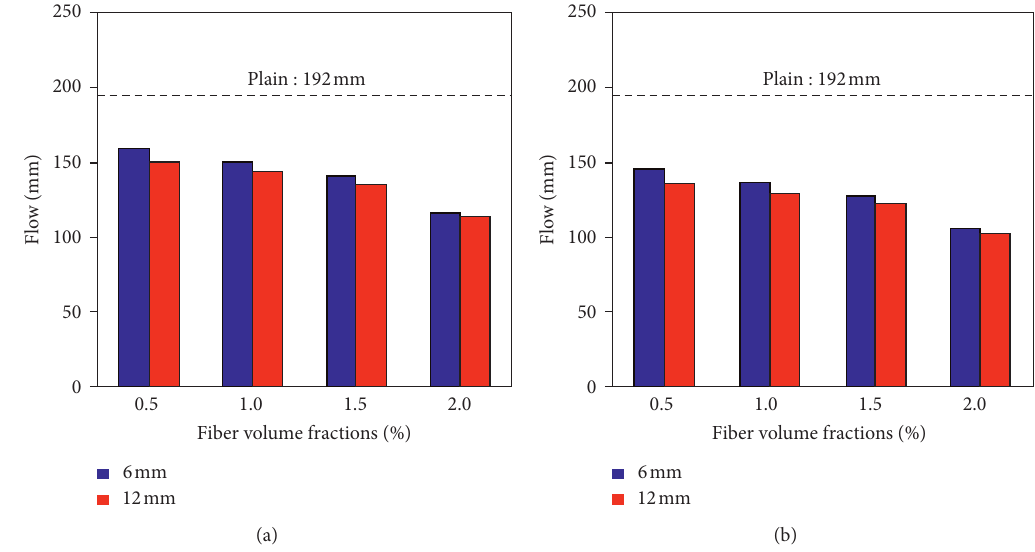
Figure 5: Flow test results with different fiber lengths and fiber volume fractions: (a) SiO